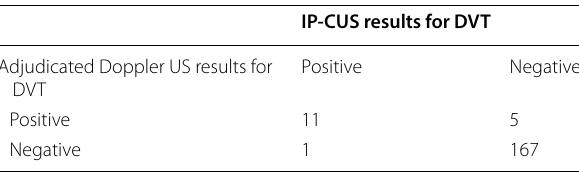
tabulation of intensivist-performed compression ultrasound findings with the